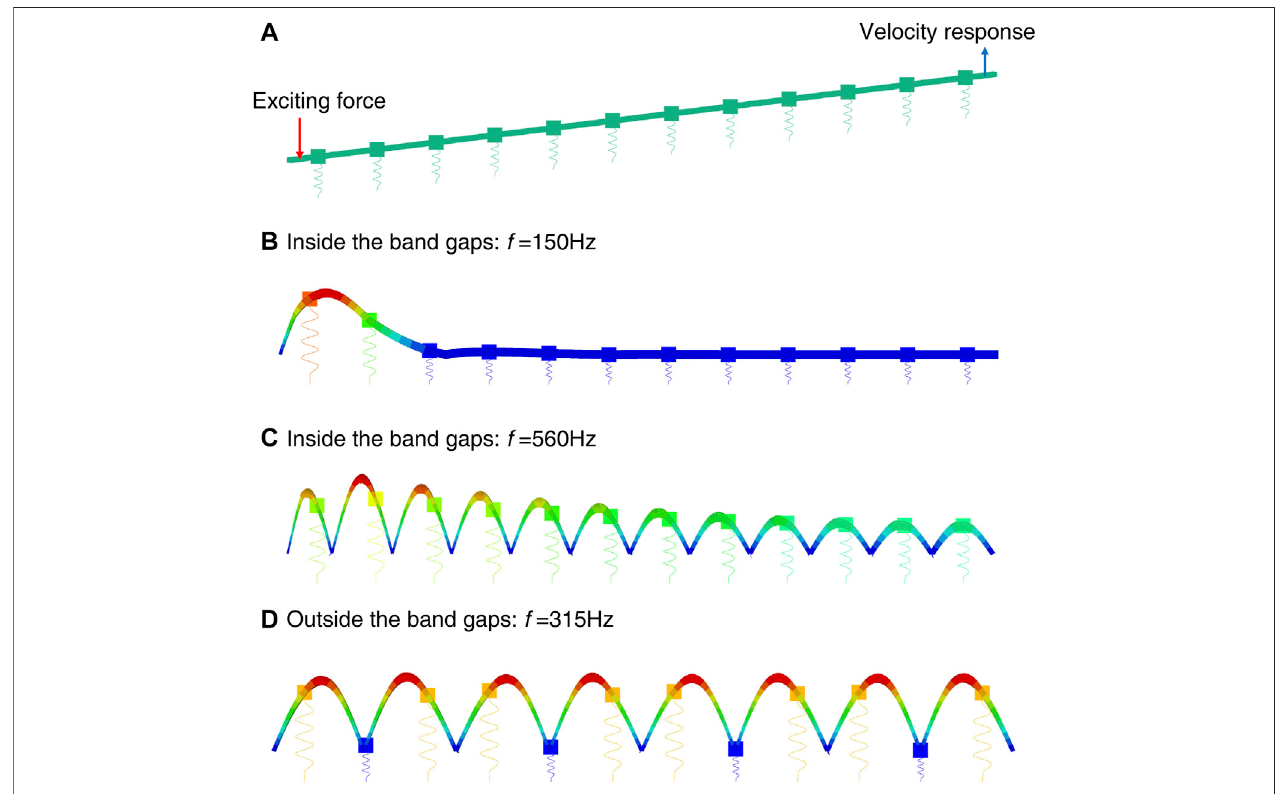
FIGURE 3 | (A) Finite element model of the fi nite long homogeneous beam coupled with periodic oscillators with 12 unit cells; (B – D) The fl exural wave vibration attenuation characteristics at particular frequencies.